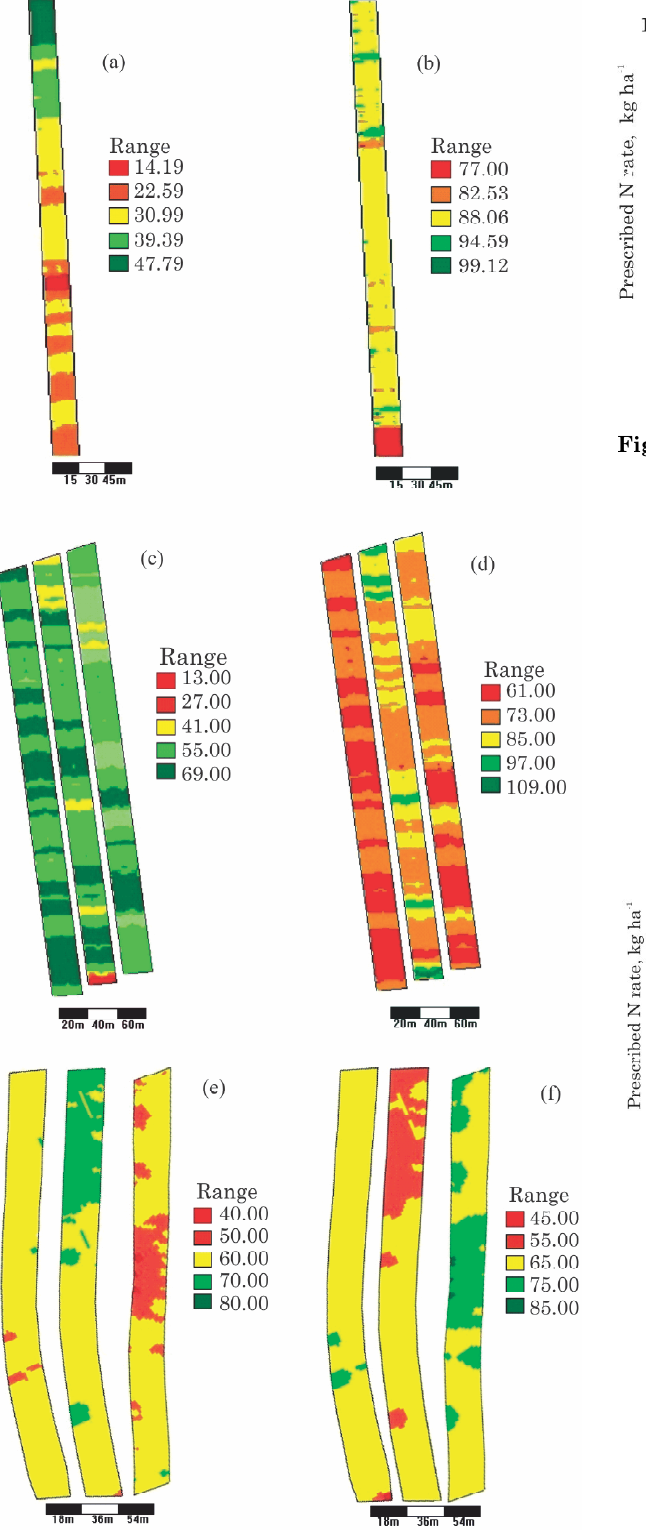
Figure 1. Vegetation index determined by the optical sensor at the phenological stage V8 of corn and the prescription of the variable-rate fertilization at sites 1 (a,b), 2 (c,d) and 3 (e,f).